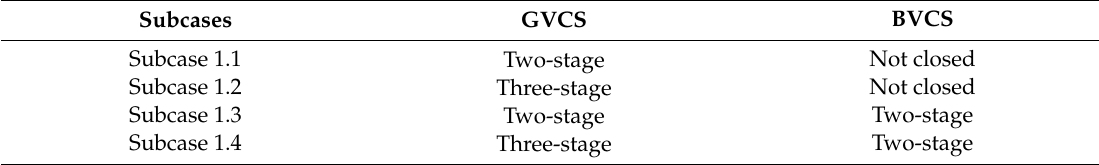
Table 4. Subcases of single-objective optimization of single load-rejection